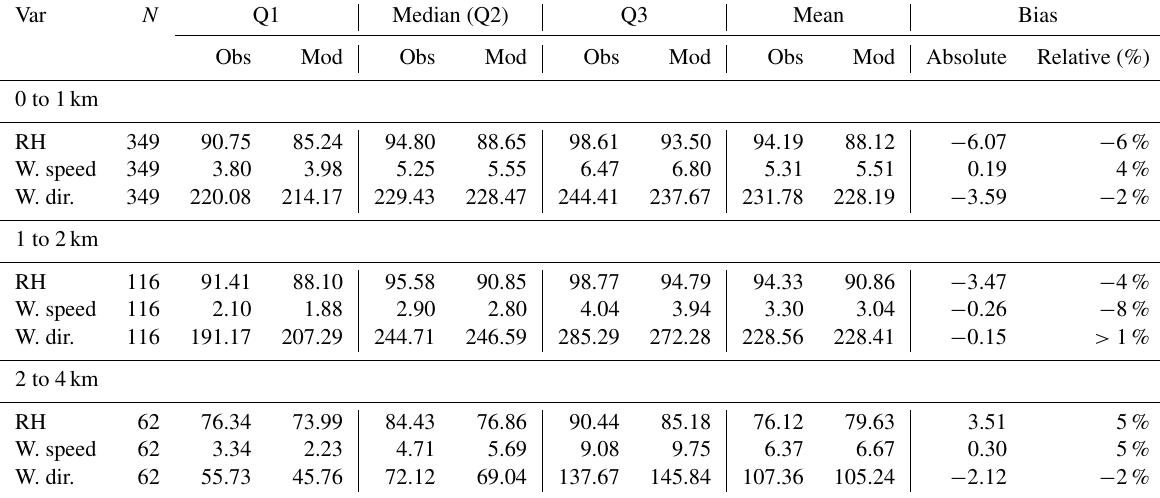
Table 4. Observed and modeled distribution (first quartile, median, third quartile), mean and bias (absolute and relative) of relative humidity (%), and wind direction ( ◦ ) and speed (ms − 1 ) measured by the three aircraft over the period of 1–7 July 2016 separated into three altitude ranges: surface to 1km, 1 to 2km, and 2 to